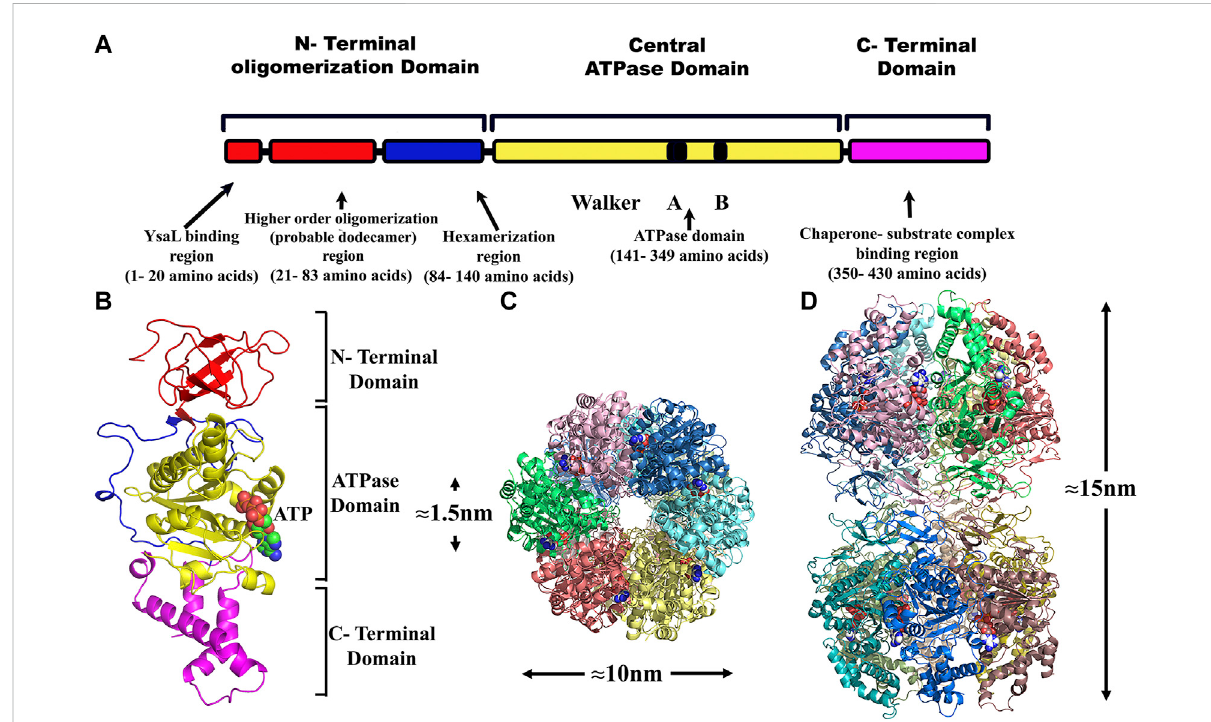
FIGURE 6 Structure modeling of YsaN and YsaN dodecamer complex- (A) - Linear representation of different predicted domains in YsaN. (B) - The model structure of YsaN is constructed on basis of FliI- FliH crystal structure ( fl agella T3SS ATPase structure PDB ID 5B0O). (C,D) - Model of probable dodecamer build by stacking two homo-hexamers through their N terminal faces following docking study. C- top view, (D) - side